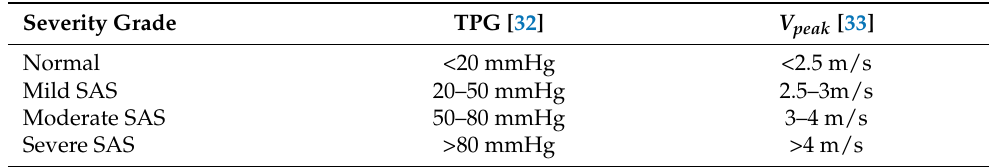
Table 1. Severity grade of subaortic